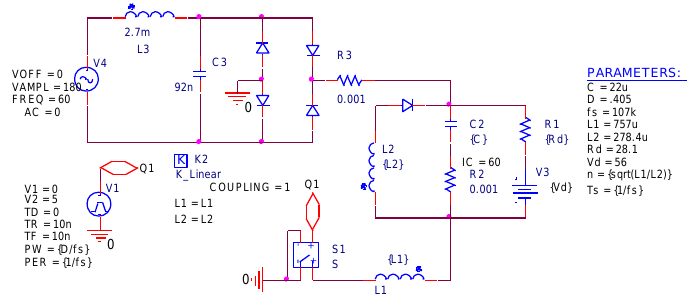
Figure 12. Proposed circuit simulated in spice.